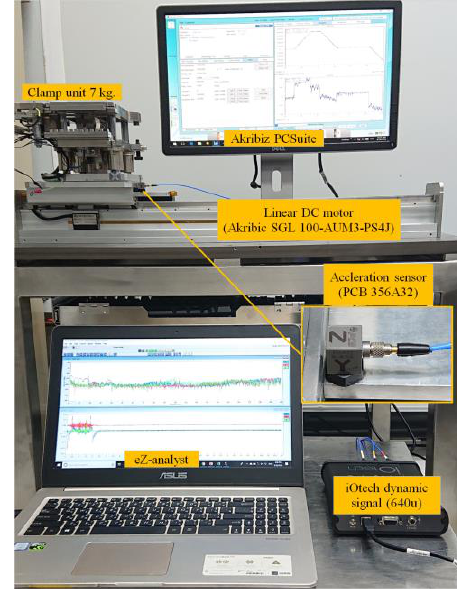
Fig . 5 Experimental setup